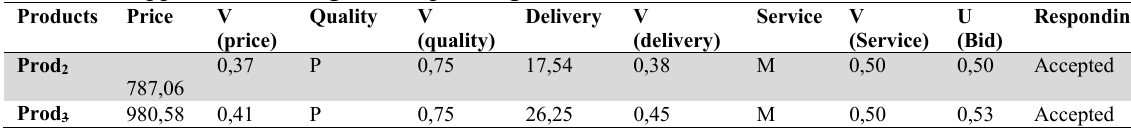
Round 6: Supplier Conceding and